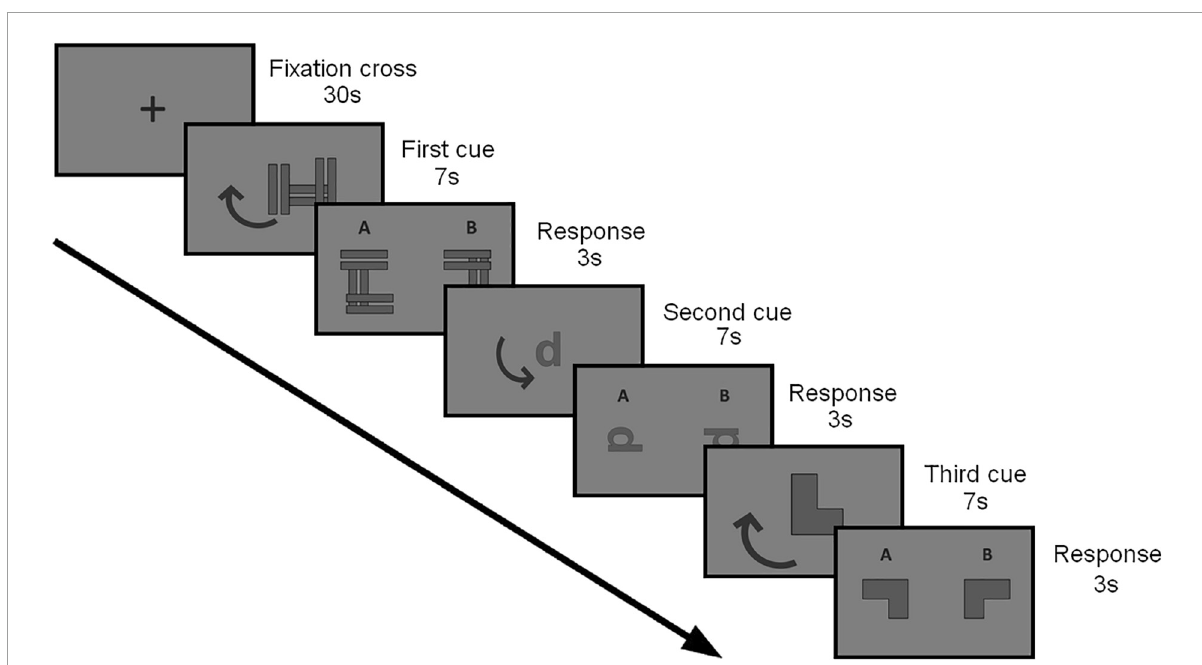
FIGURE2 Schematic diagram of the experimental procedure. Fixation cross (the 30 s) was followed by the first cue (7 s) as one gray abstract figure placed on the center of the slide with a gray arrow indicating the left or right direction of rotation. A stimulus “response” was then presented (3 s) as a pair of gray abstract figures identified as “A” and “B” with a similar form, but different orientations at 90 ◦ according to the cue (to the right or left visual field) so the participants could answer verbally. The child had 30 s to rest, 7 s to imagine the rotated geometric figure, and 3 s to choose the alternative, three times per block, yielding 30 s of